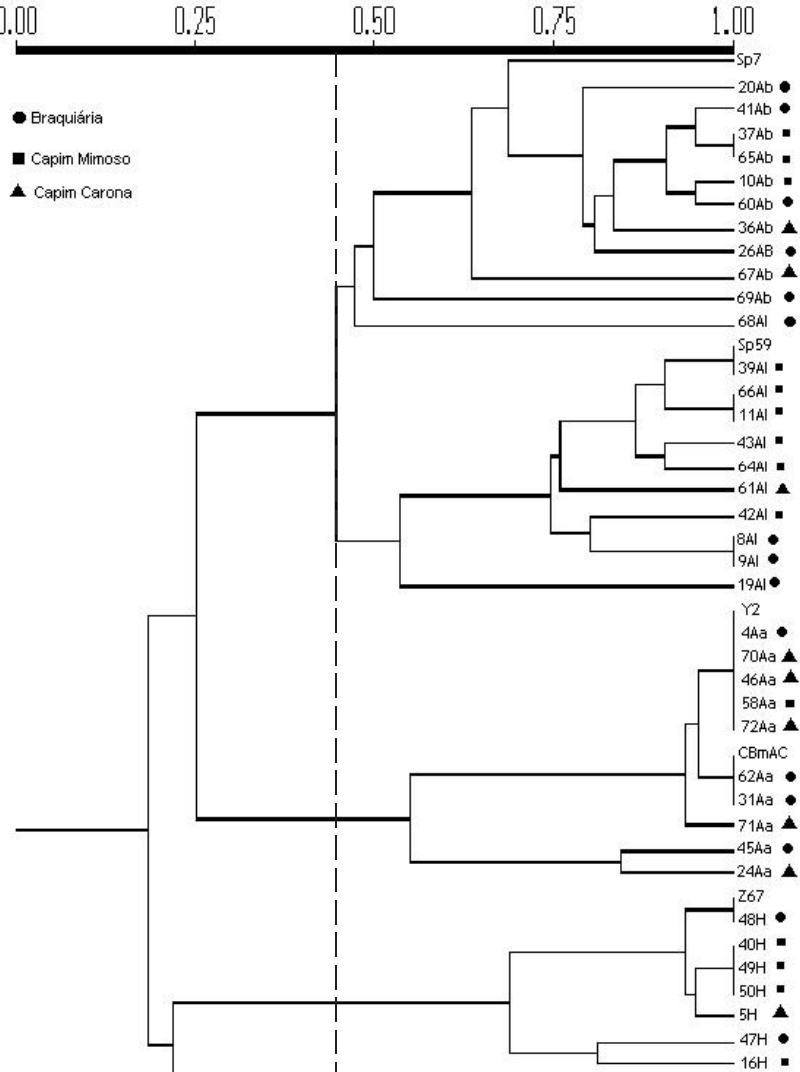
Figura 3. Dendrograma de similaridade (UPGMA) de 39 isolados de bactérias diazotróficas caracterizadas como A. brasilense (Ab), A. lipoferum (Al), A. amazonense (Aa), Herbaspirillum seropedicae (H), obtidos de 3 espécies de gramíneas forrageiras do Pantanal do Mato grosso do Sul, e cinco estirpes tipo usadas como referência (Sp7, Sp59, Y , CBAmC e Z67). Nível de similaridade aproximado de 25 % 2 (0,25) (I a V), sendo (r) o coeficiente cofenético =